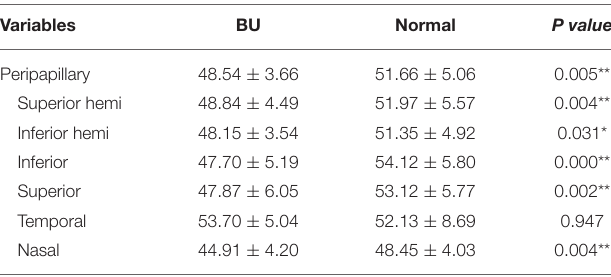
TABLE 3 | Comparison of Vascular Density in the RPCN between BU and Normal Eyes. Variables